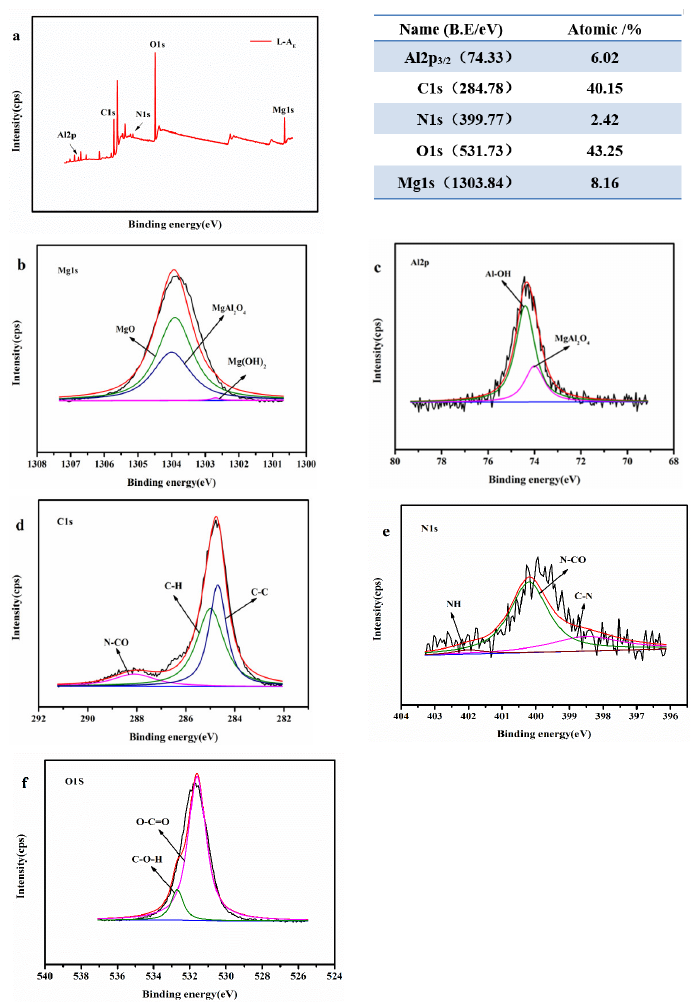
Figure 5. ( a ) XPS survey spectrum and high-resolution spectra of ( b ) Mg1s, ( c ) Al2p 3/2 , ( d ) C1s, ( e ) N1s and ( f ) O1s of L-A E .